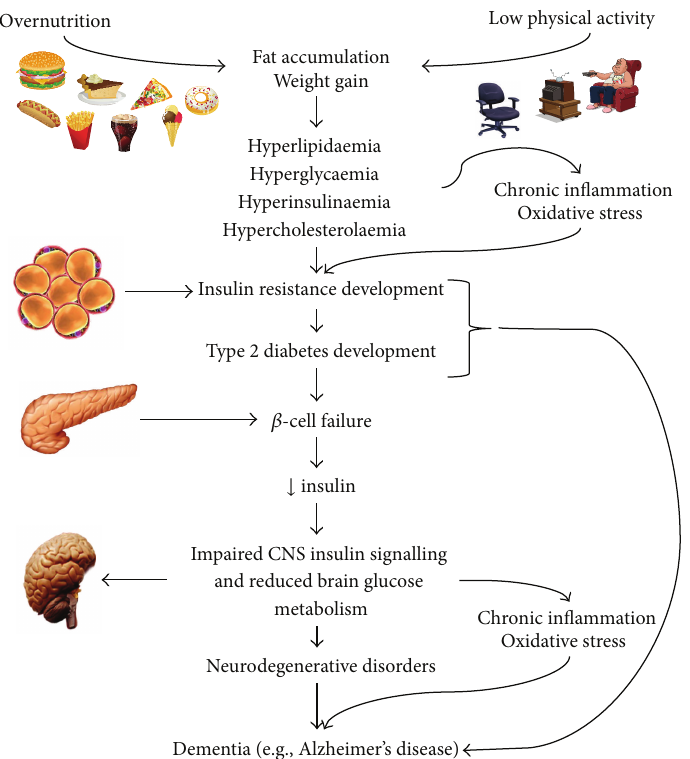
Figure 1: Neurodegeneration, insulin resistance, obesity, and T2DM. Metabolic overload, chronic inflammation, and oxidative stress promote cellular dysregulation in both T2DM and AD. Brain IR may occur in the absence of diabetes suggesting that AD may develop in the earlier stages of insulin resistance. Chronic inflammation and oxidative stress are considered two key factors linking diabetes and AD